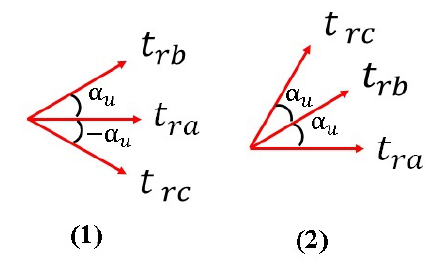
Figure 6. Phase shifting between carriers’ signals: the results of the analysis are the same regardless of the reference ( 1 , 2 ) if the three PWM carriers’ signals have equal mutual phase